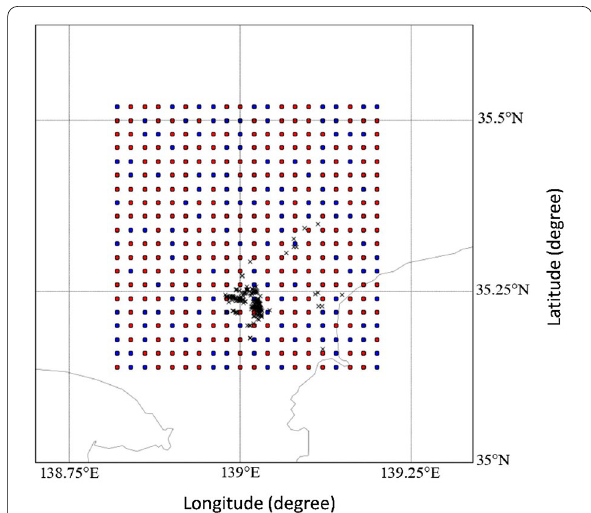
Fig. 2 Red dots are the earthquakes used for learning and blue dots are the earthquakes used for testing. The size of the dots is proportional to the magnitude. Crosses are epicenters of observed earthquakes. The total number of earthquakes used is 2632 and we used 2236 events as the training data set. Some of the earthquakes are removed from the data set due to apparent numerical problems during the simulation